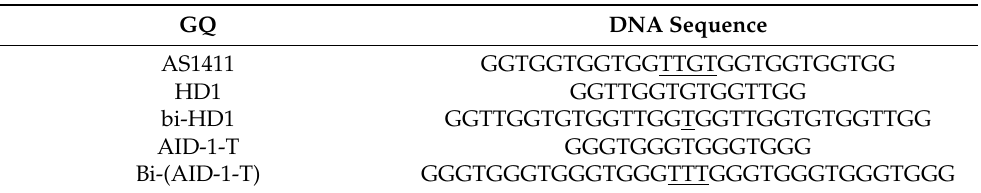
Table 2. List of GQ sequences of DNA oligonucleotide under study. Proposed sequences of linkers of GQ modules are underlined. References for known GQ are in the